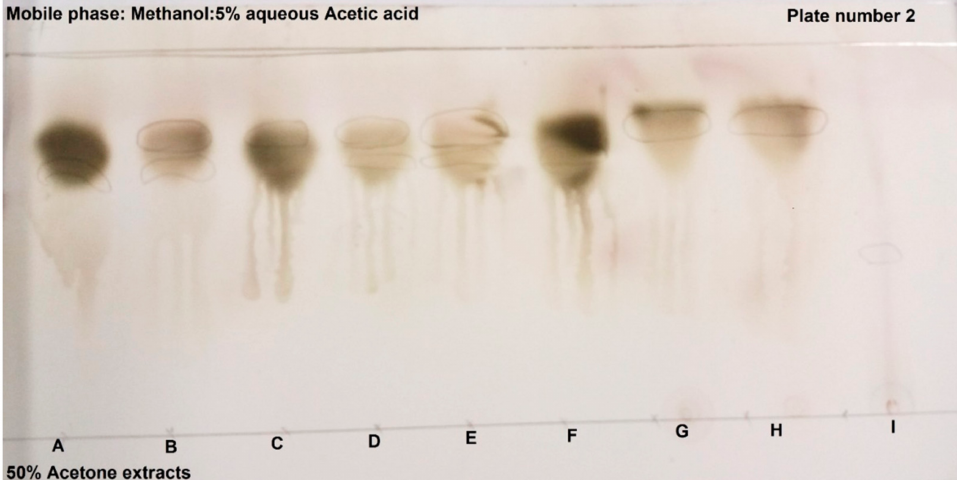
Figure 2. TLC was sprayed with vanillin reagent mixture, ( A ) Ficus Indice; ( B ) Monterey; ( C ) Meyers;